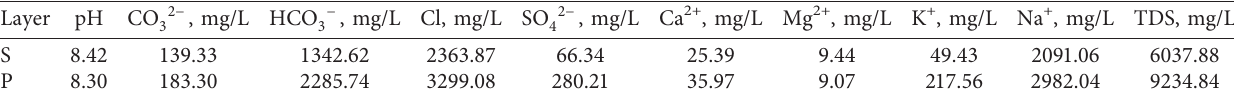
Table 14: Daqing formation brine composition